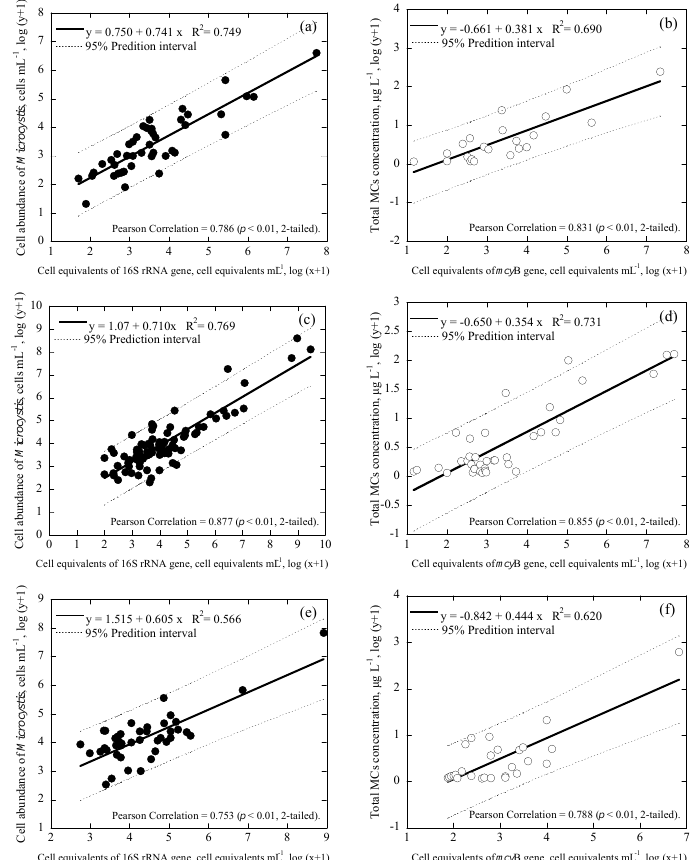
Figure 4. Correlation between cell abundance, toxin concentrations and cell equivalents in the duplex Microcystis system with 95% prediction interval (broken line), where represents cell equivalents of 16S rRNA gene, represents cell equivalents of mcy B gene, ( a ) and ( b ) are for all the data from Taiwan main island (number of samples, n = 44 and 22), ( c ) and ( d ) are for Kinmen islands ( n = 86 and 38), and ( e ) and ( f ) are for Matsu islands ( n = 43 and 27).